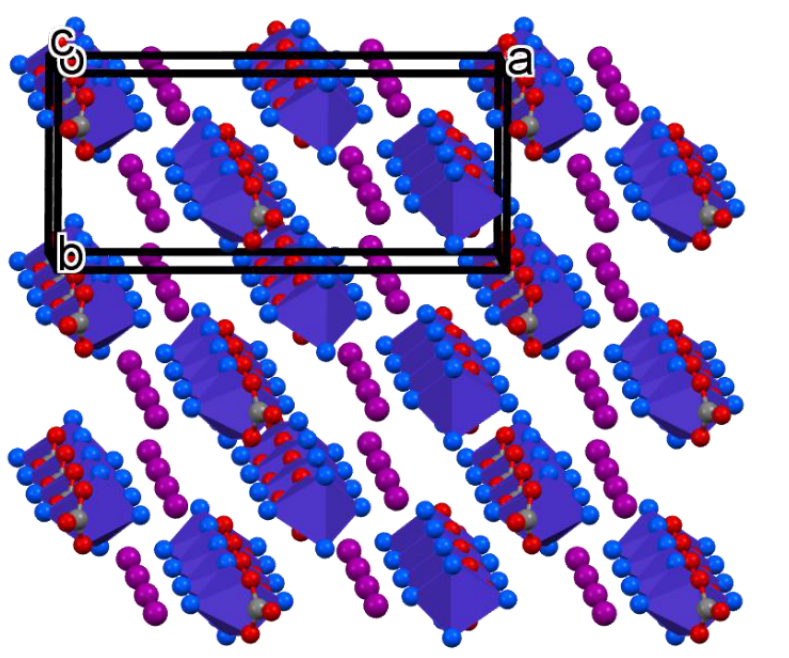
Figure 2. Packing arrangement in the crystal lattice of [Co(NH 3 ) 4 CO 3 ]I (a, b, c are axes marks and o is the origin).